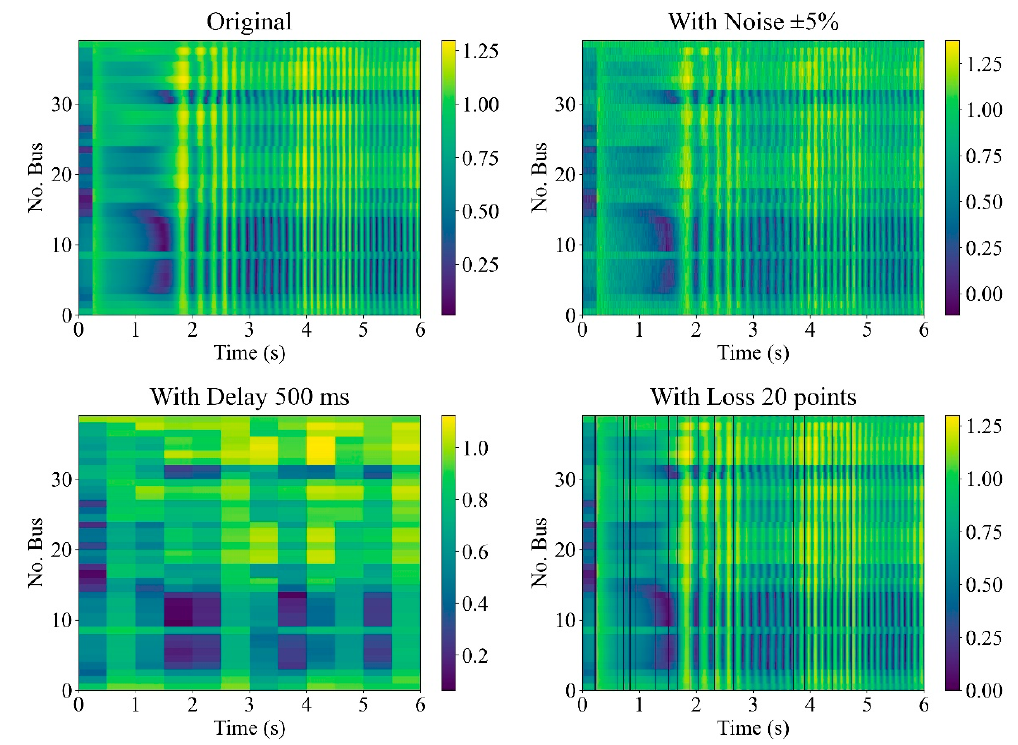
Figure 8. Colormap representation of voltage magnitude response in unstable case.